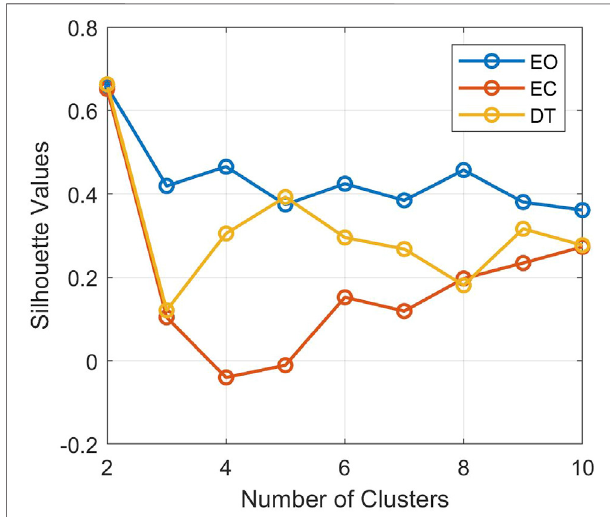
FIGURE 3 | Silhouette spectral cluster evaluation for the three shrink regression spaces in eyes opened (EO), eyes closed (EC), and dual task (DT) conditions. Note that the optimal numbers of clusters is given in correspondence to the maximum of the silhouette values.